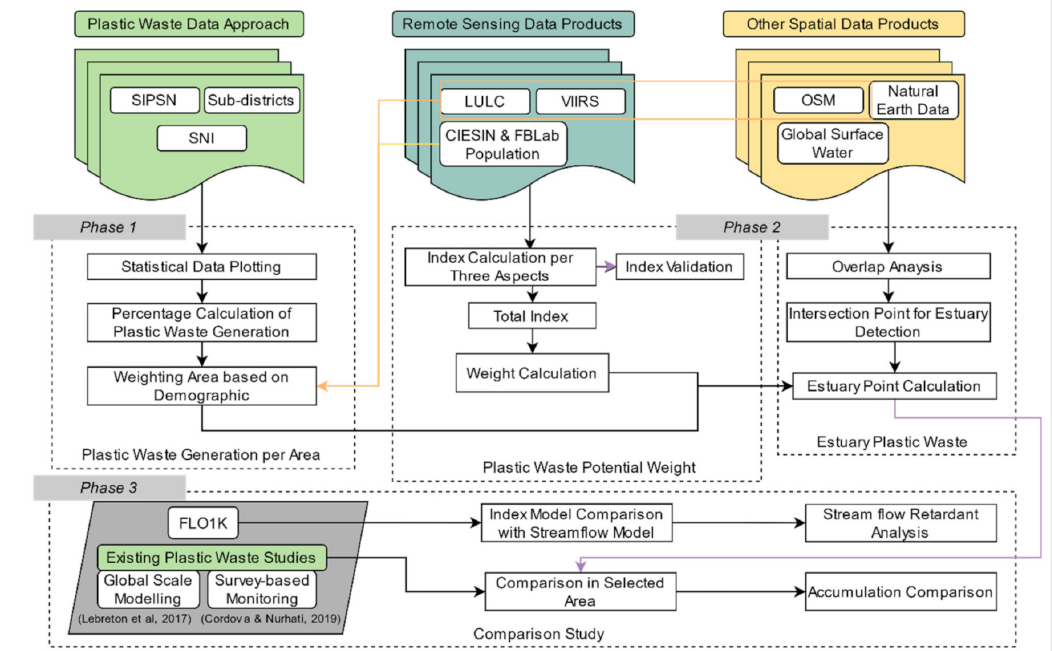
Figure 1. The overall framework of this study.